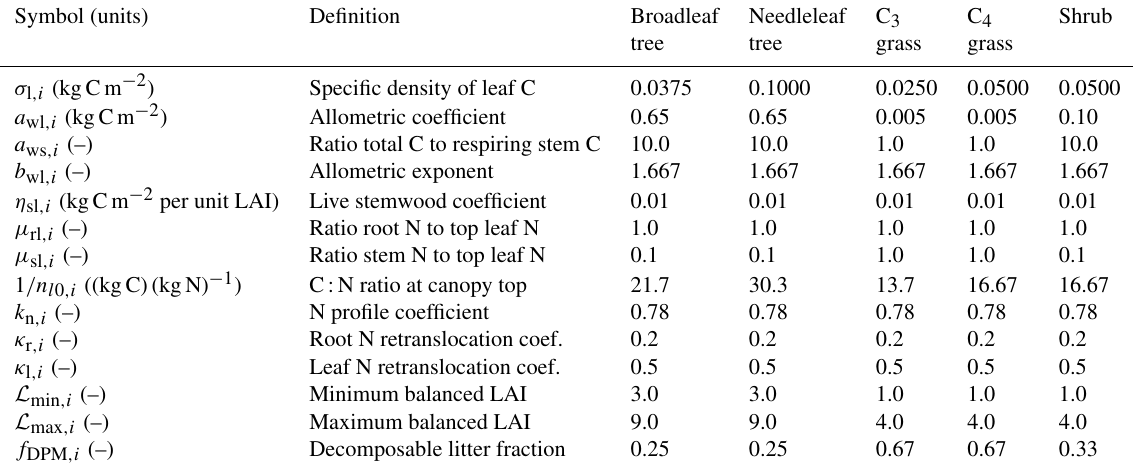
Decomposable litter